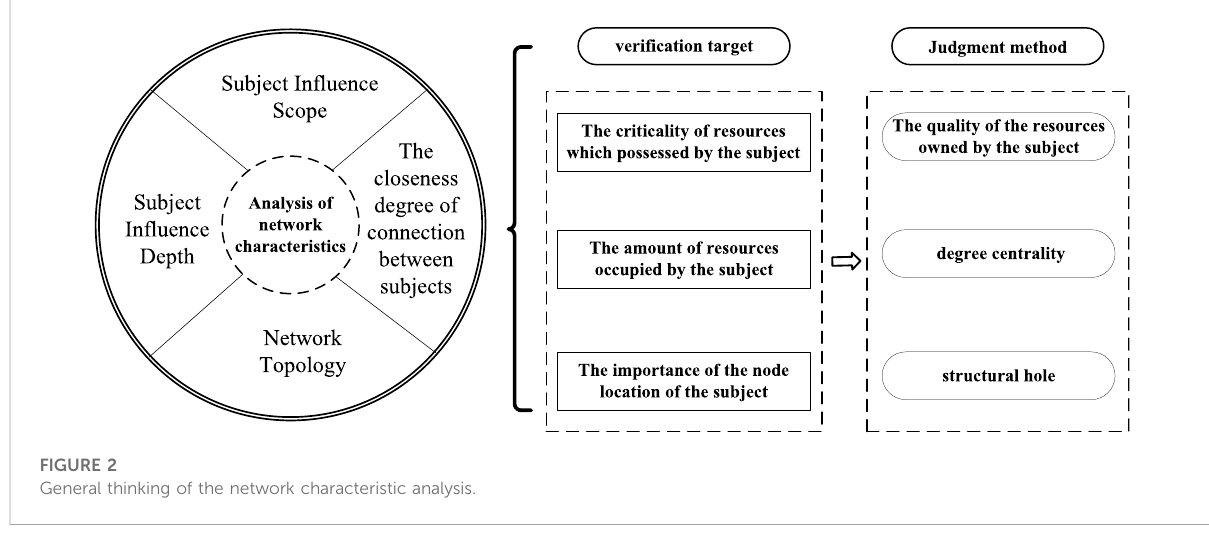
FIGURE 2 General thinking of the network characteristic